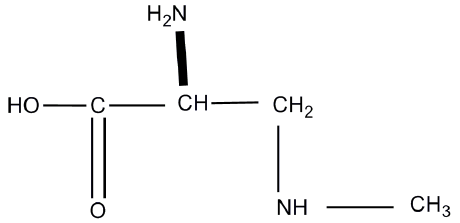
Figure 1. The chemical structure of β -methylaminoalanine